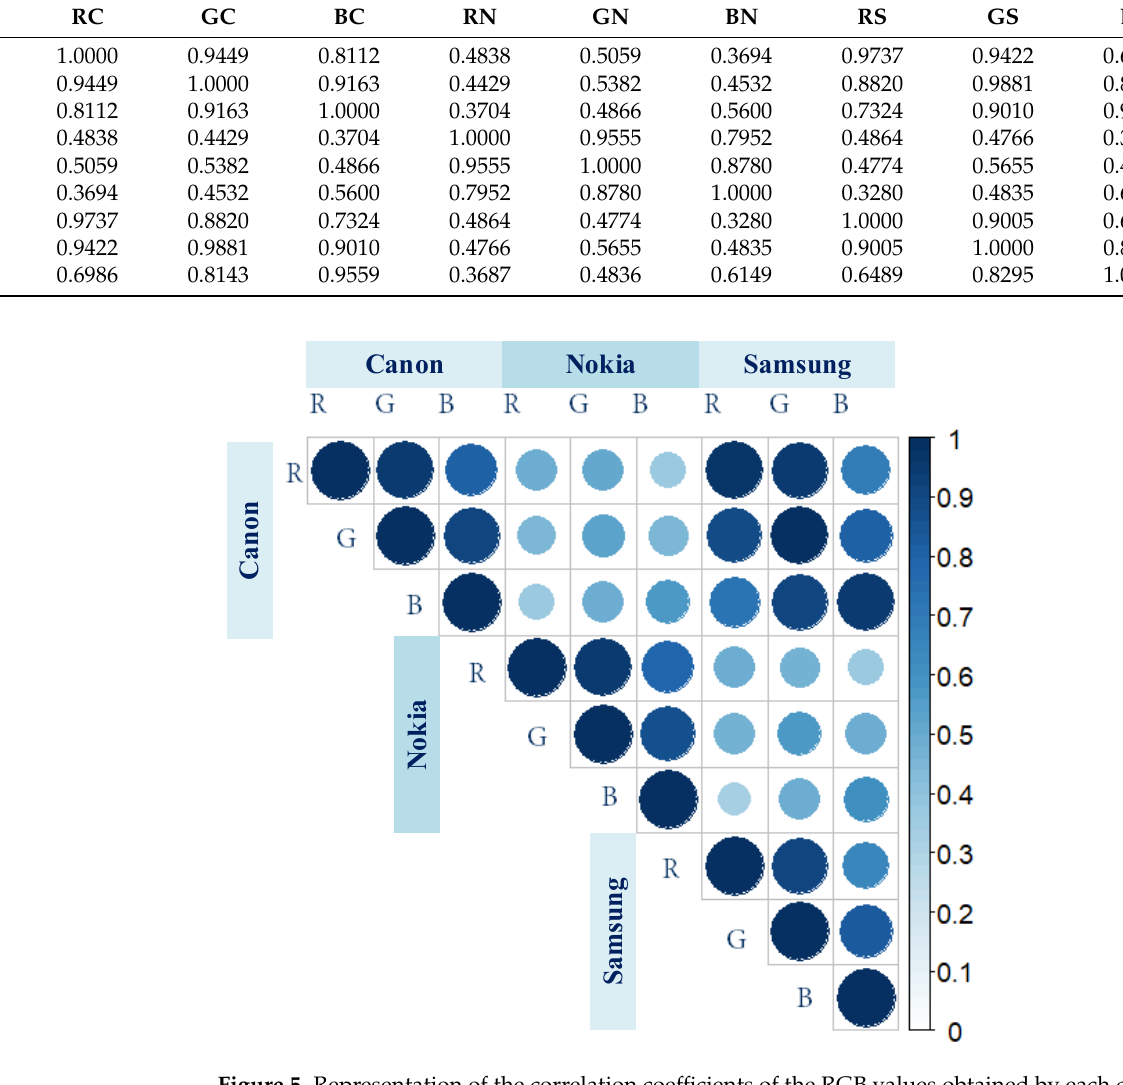
Figure 5. Representation of the correlation coefficients of the RGB values obtained by each device.